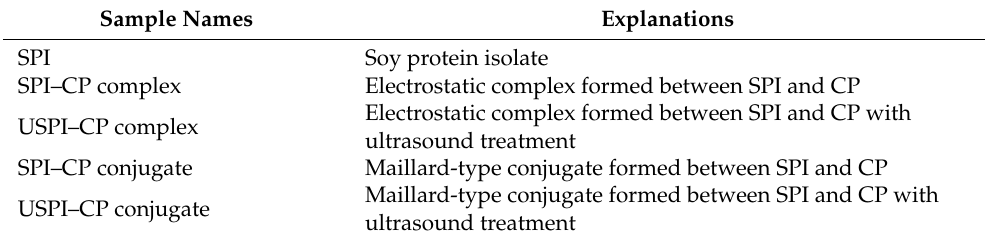
Table 1. Abbreviations and explanations of sample